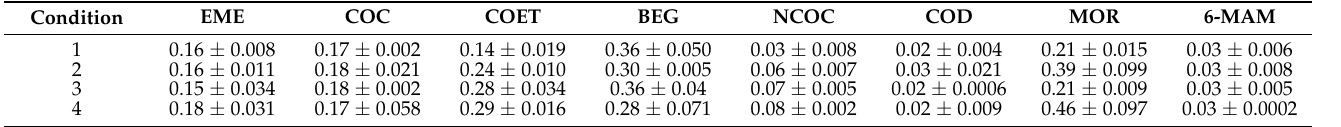
Table 2. Responses obtained for the assay without preservative.